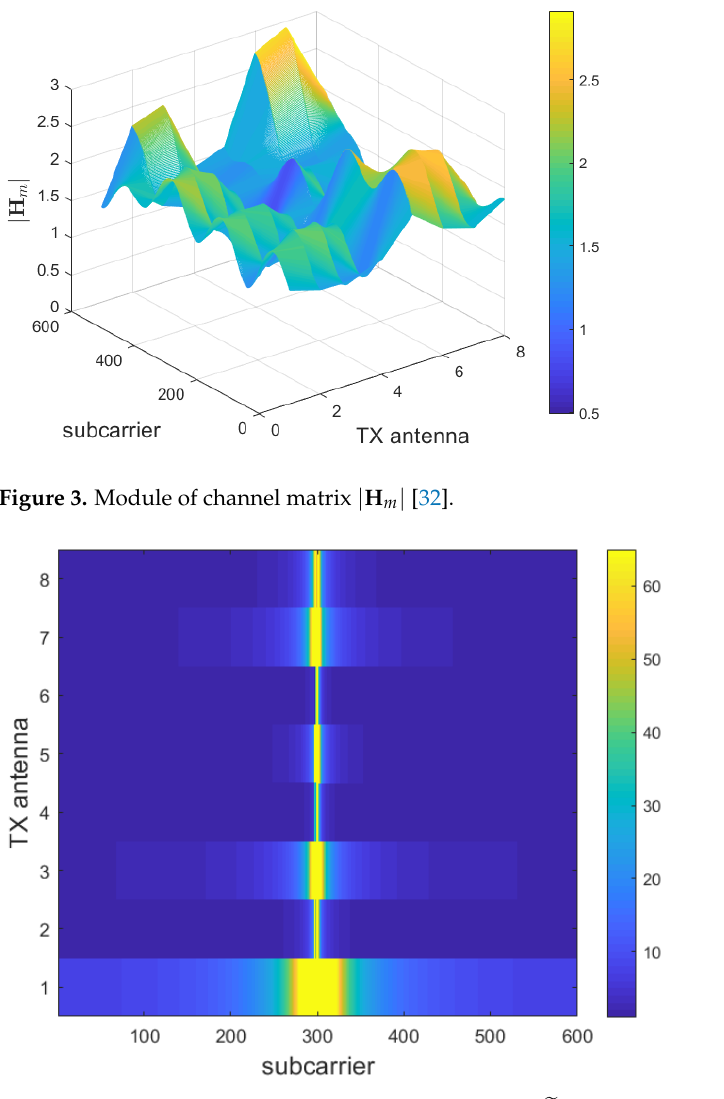
Figure 4. Module of DFT-transformed channel matrix | (cid:101) H m |